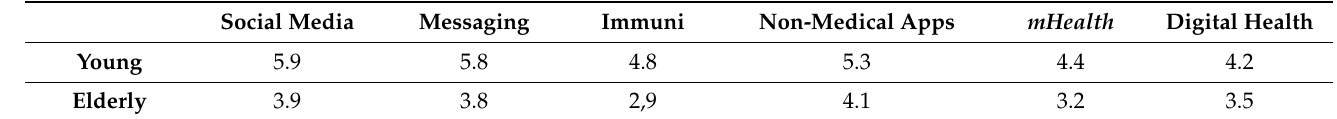
Figure 9. Differences in the degree of familiarity with mHealth ( p = 0.008) processes and the Digital Health ( p = 0.009) for young * people and the elderly. Table 2. Trends in the two